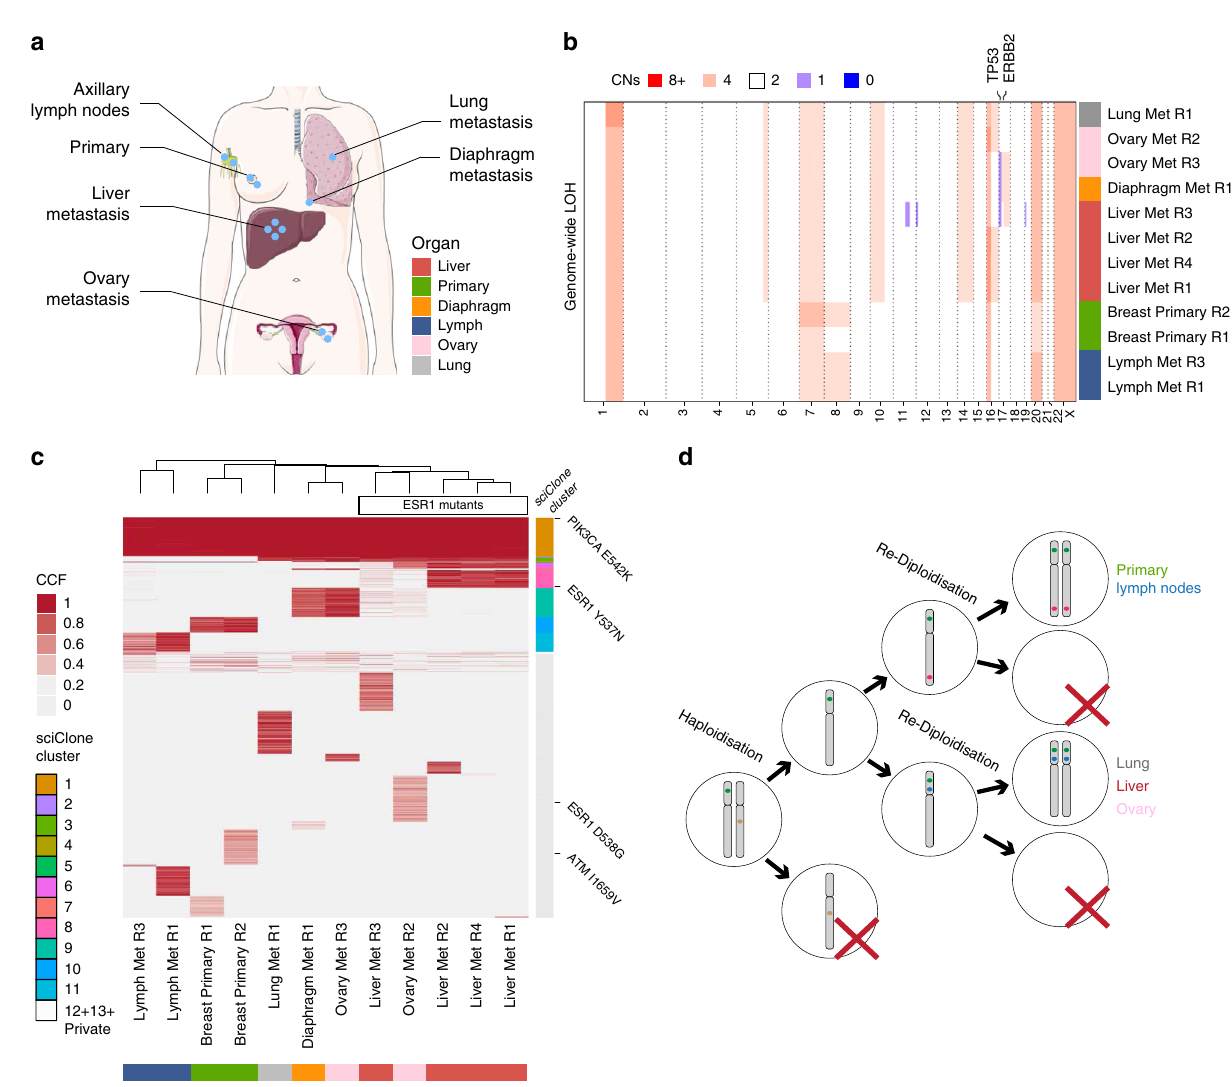
Fig. 1 Genomic pro fi ling analysis of LEGACY patient 1. a Multiple samples from distinct metastatic deposits in different organs and the primary tumour were collected from this patient, together with blood germline reference (buffy coat) and plasma. b Copy number alterations analysis highlights genome- wide copy neutral LOH and overall homogeneous copy number pro fi les. Median total copy number in 1 Mb bins with a minimum mappability score of 0.8. c Single-nucleotide variant analysis identi fi ed a clonal PIK3CA driver mutation and convergent evolution for drug resistant ESR1 mutants. SNVs detected in more than one sample were clustered with sciClone (colour bar reported to the right of heatmap, see sciClone Cluster legend). d Diagram of inferred genome-wide copy neutral LOH event that can be explained by haploidisation followed by convergent re-diploidisation after a few cell